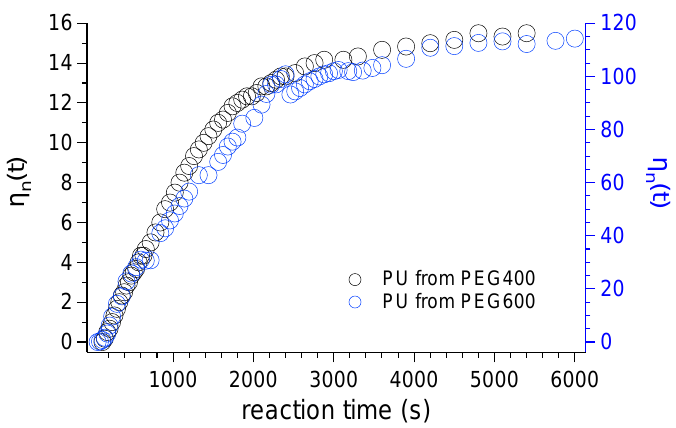
Figure 2. Relative viscosity variations ( η n (t )) as a function of the polymerization time using PEG400 (open black circles) and PEG600 (open blue circles) as diols.